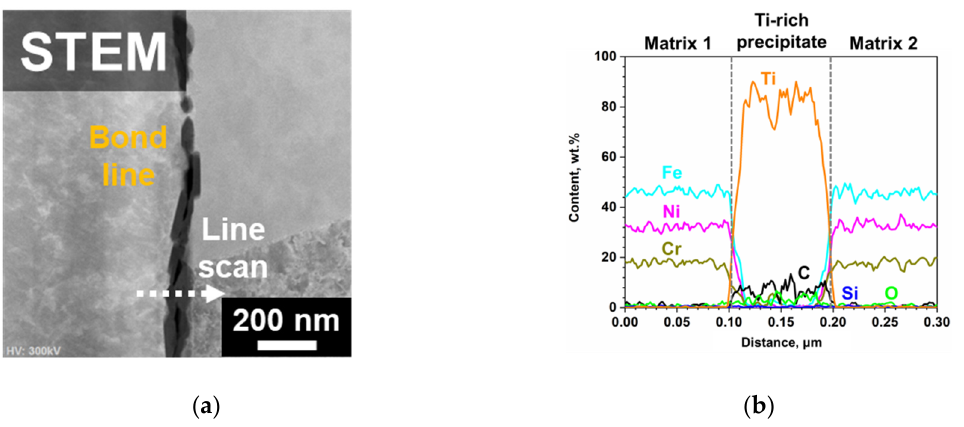
Figure 3. TEM analyses results of di ff usion bonded Alloy 800HT at the bond-line; ( a ) STEM micrograph and ( b ) EDS line scan results.